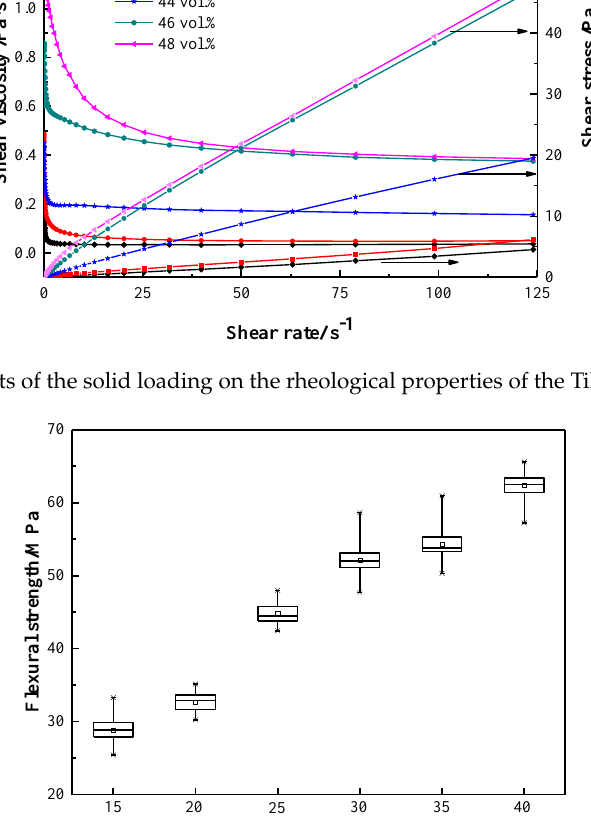
Figure 5. E ff ect of monomer content on flexural strength of dried bodies derived from the 46 vol %